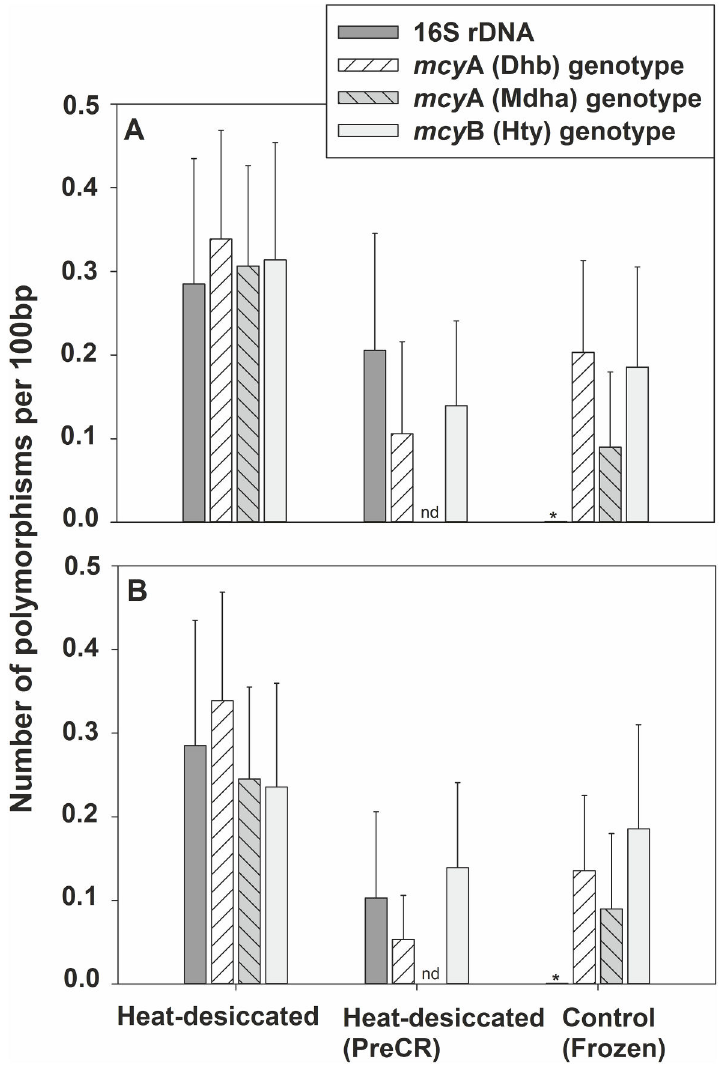
Figure 2. Number of substitutions found in gene loci used for qPCR and detected by sequencing from heat-desiccated DNA, an aliquot treated with the PreCR Repair Mix, and DNA from a frozen sample. (A) Number of substitutions; (B) number of substitutions in the primer sites (per 100 bp). *, no substitutions detected; nd, no data. doi: 10.1371/journal.pone.0080177.g002 obtained from the frozen sample but 2% ( n = 57) and 1% ( n = 81) of sequences obtained from the treated and untreated DNA aliquot, respectively were affected by transversions.